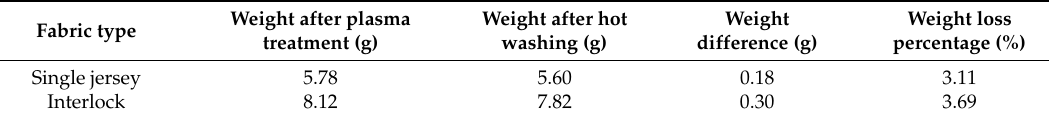
Table 4. Weight loss of plasma-treated knitted fabric with hot (70 ◦ C) washing (plasma condition: 150 W output power and 0.4 L/min flow rate).